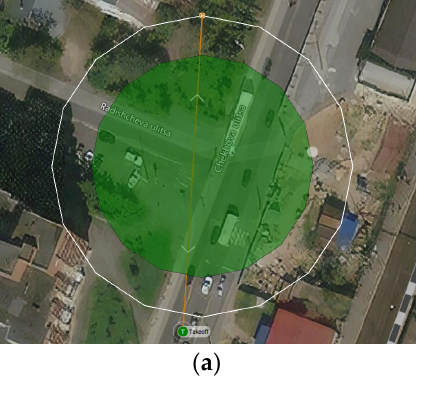
Figure 2. Examples of trajectories for the reconstruction of an accident: ( a ) shows the first type of trajectory; ( b ) the second type of trajectory.